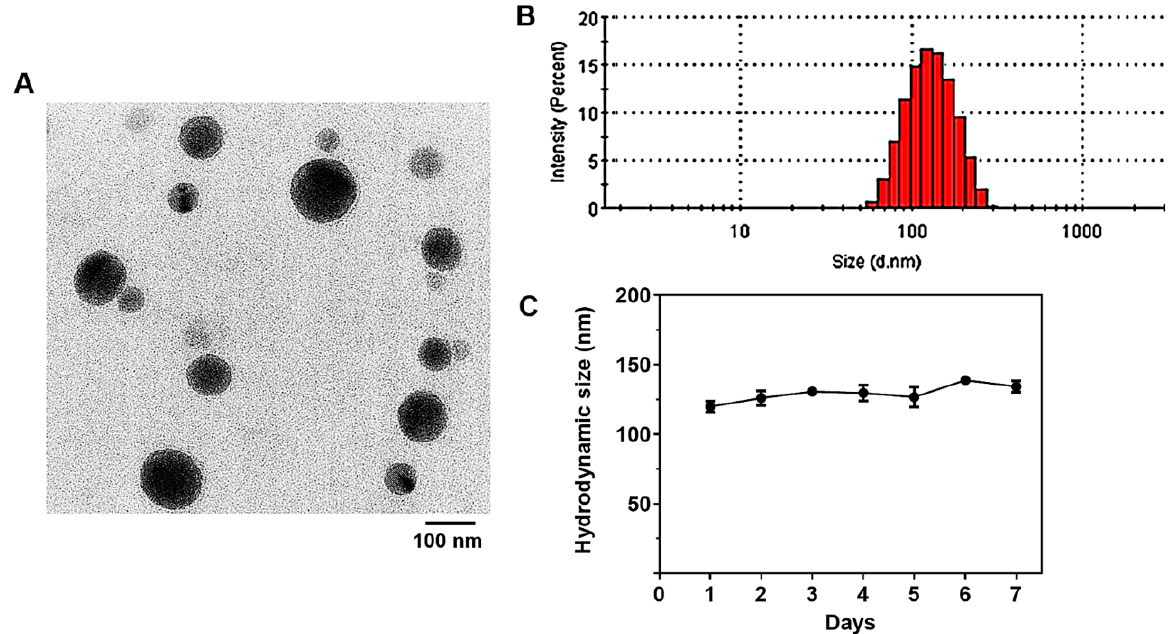
Figure 1. Physical characterizations of BSA-Silver NPs: ( A ) representative TEM images, ( B ) mean hydrodynamic size measured by dynamic light scattering, and ( C ) size stability. (BSA-Silver NPs: BSA-coated silver nanoparticles, TEM: transmission electron microscopy).